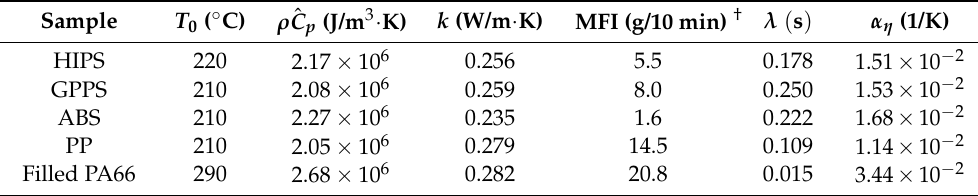
Table 1. Fluid properties of polymer